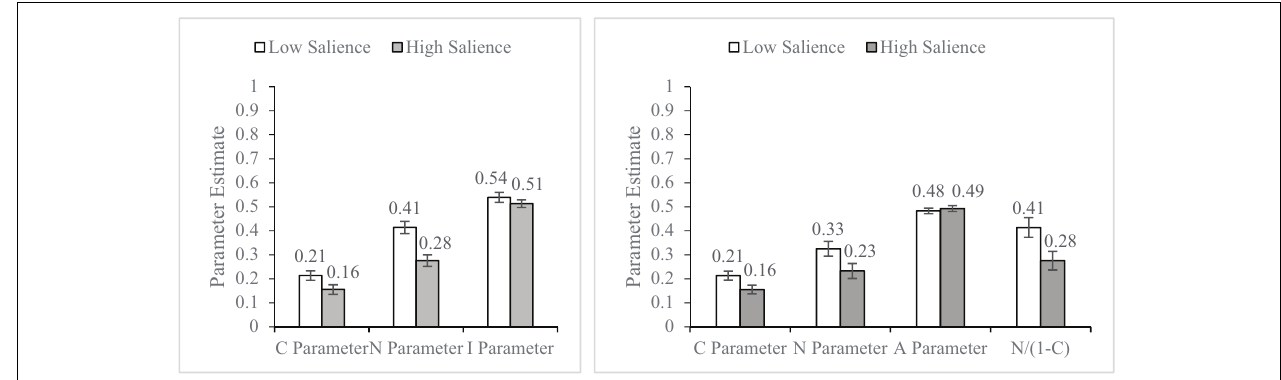
FIGURE A8 | Results of Study S1b by Gawronski et al. (2017) obtained from the CNI model (left) and CAN algorithm (right) . Error bars represent ± 1 SE.